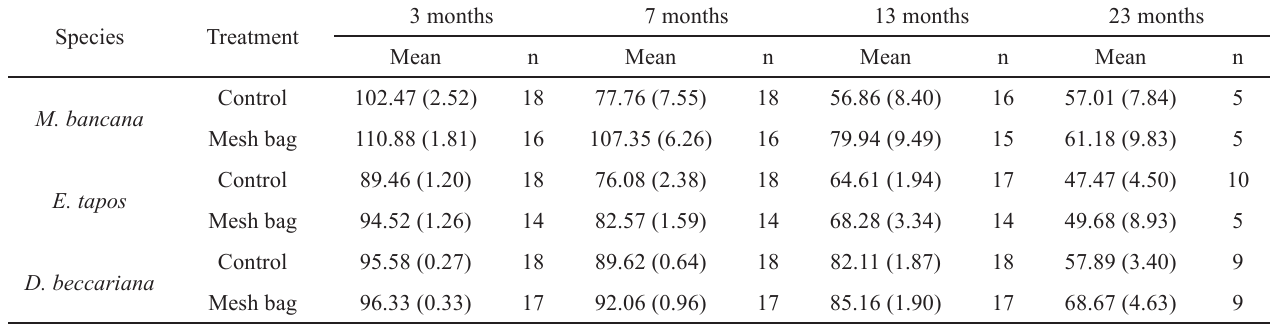
Table S1 . Mean mass remaining (± SD; %) of M. bancana , E. tapos , and D. beccariana during the 23 months. n = the number of samples.